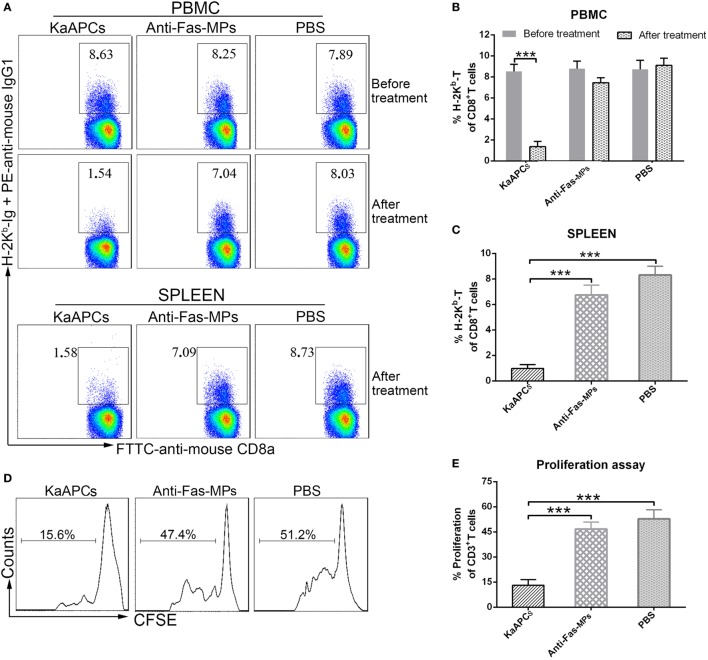
Killer artificial antigen-presenting cells (KaAPCs) deplete alloreactive T cells in vivo and inhibit the anti-donor alloreactivity of recipient T cells. Recipient bm1 mice were treated with KaAPCs, anti-Fas-MPs, or PBS on days 9, 11, and 13 after transplantation. Peripheral blood was collected on day 8 (1 day before treatment) and day 15 (2 days after treatment), and spleens were also collected on day 15. (A–C) H-2Kb-Ig dimers staining and flow cytometry. The representative dot plots were presented in panel (A) and were gated on CD8+ T cell population. Infusions of KaAPCs resulted in a marked reduction of H-2Kb-alloreactive CD8+ T cells in the CD8+ T cell populations from peripheral blood (B) and spleen (C). (D,E) Anti-donor mixed lymphocyte reaction assays. Splenocytes from the recipient bm1 mice in each treatment group were labeled with carboxyfluorescein succinimidyl ester (CFSE) and cocultured with mitomycin C-treated splenocytes, which derived from donor C57BL/6J mice, in 96-well microplates for 7 days. The proliferation percentage of recipient CD3+ T cells was determined according to cell divisions (D). KaAPCs treatment inhibited the anti-donor alloreactivity of recipient CD3+ T cells (E). n = 4–6 mice in each group. ***p < 0.001.